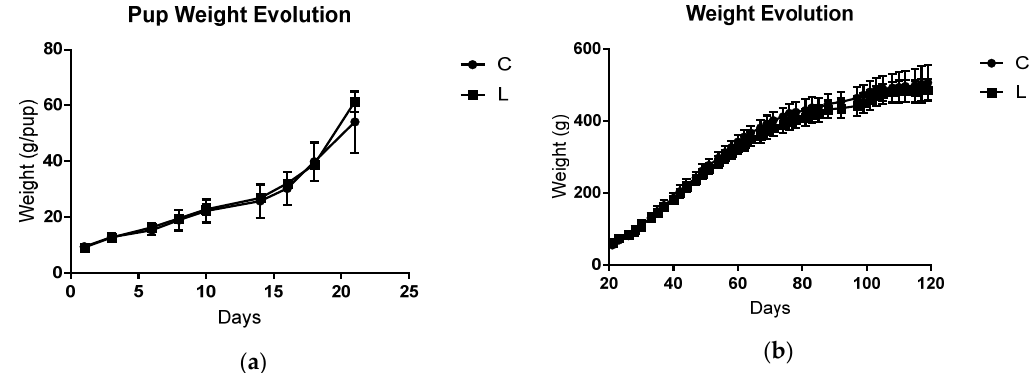
Figure 2. Offspring body weight evolution. ( a ) Pup weight evolution (g) during lactation until the